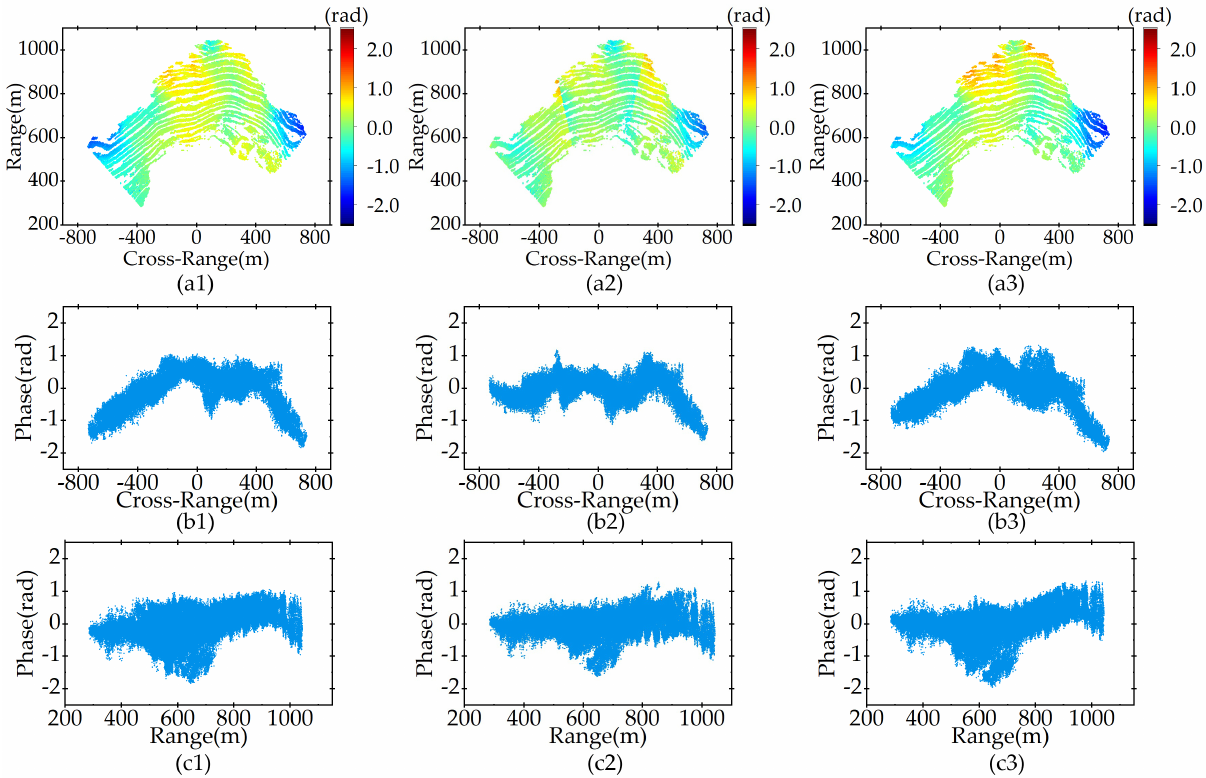
Figure 12. Correction results by the three regression model-based methods and the distribution of the corrected phases along the different directions: ( a1 – a3 ) are the atmospheric phase correction (APC) results of the 2nd-order slant-range model, the 2nd-order slant-range model with azimuthal partition, and the slant distance & azimuth model, respectively, ( b1 – b3 ) are the distributions of the corrected phase along the cross-range direction, and ( c1 – c3 ) are the distributions of the corrected phase along the range